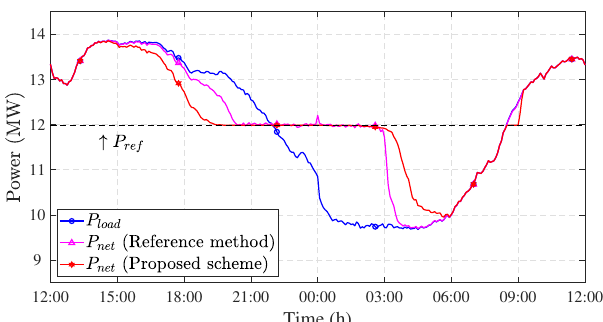
Figure 14. Net load profile of the feeder utilizing the method from Reference [22] and the proposed